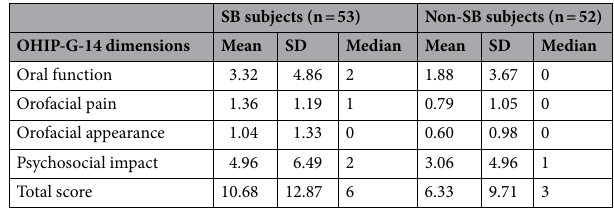
Table 4. Descriptive data of OHIP-G-14 of SB and non-SB subjects (n = 105). SB sleep bruxism.